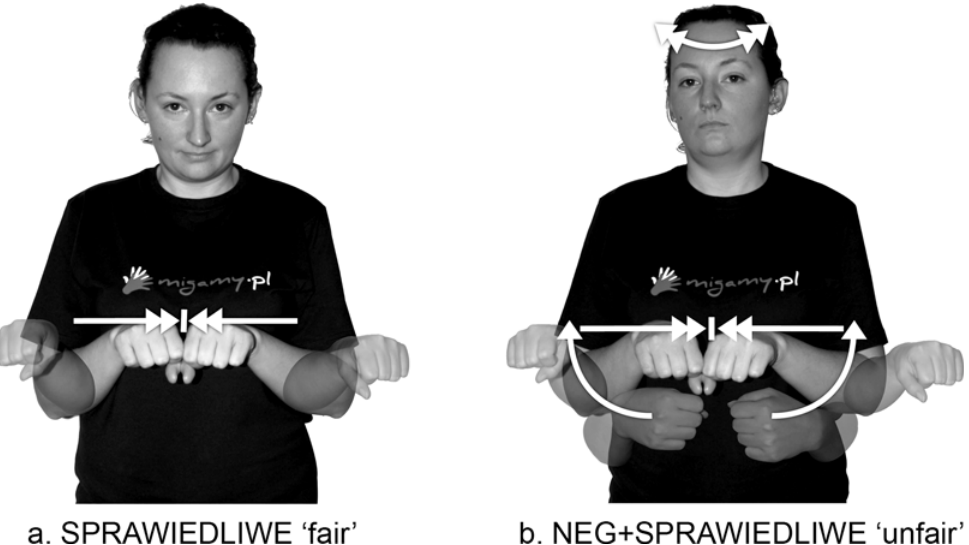
Fig 9. The PJM signs SPRAWIEDLIWE ‘ fair ’ and NEG+SPRAWIEDLIWE ‘ unfair ’ . The individual in this figure has given written informed consent (as outlined in PLOS consent form) to publish these case